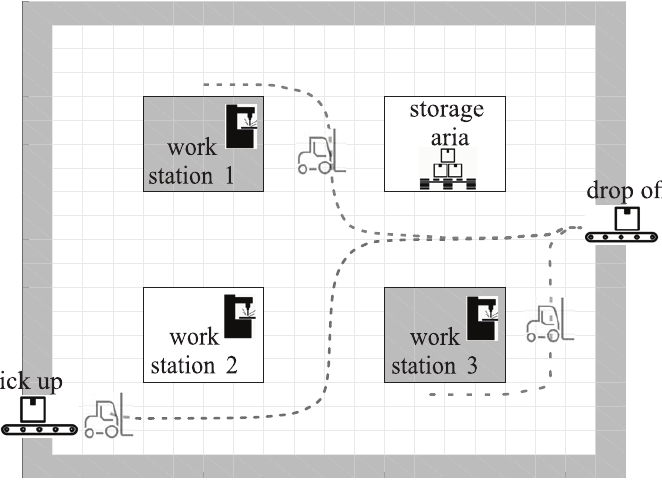
Figure 1. Production layout with multiple known and fixed delivery points and defined free corridors. Shown are robot delivery paths from three starting locations to the same destination. The paths can be effectively determined by a single navigation function, as shown in Figure